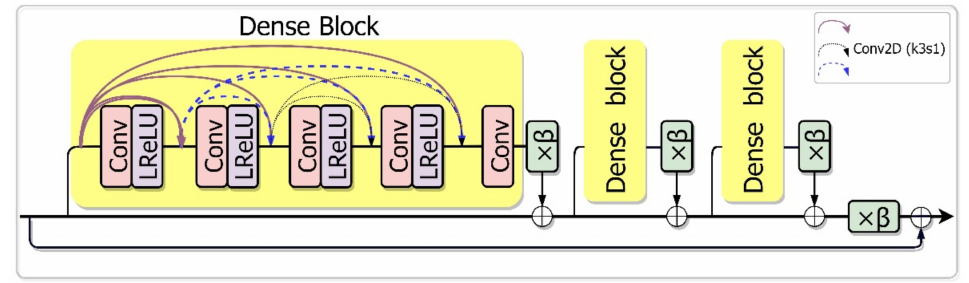
Figure 3. Structure diagram of RRDB (convolution kernel size k = 3, stride s = 1, scaling factor α =